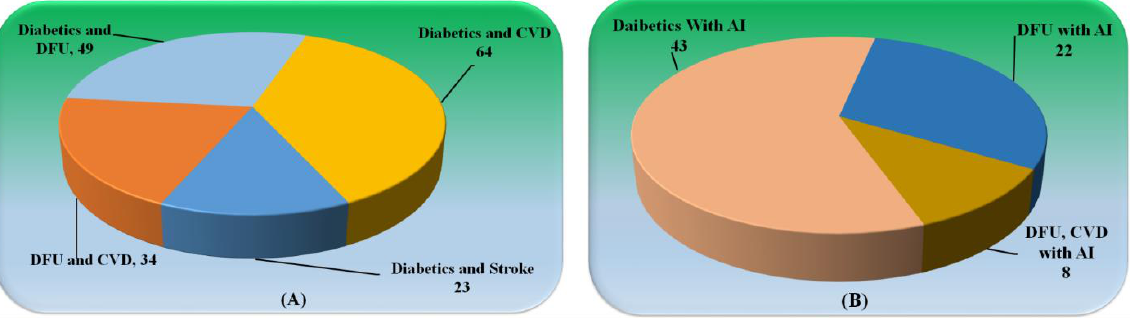
Figure 2. ( A ) Studies related to Diabetics with CVD, Stroke, and DFU. ( B ) Studies explaining the role of AI in Diabetics with DFU and CVD. of AI in Diabetics with DFU and